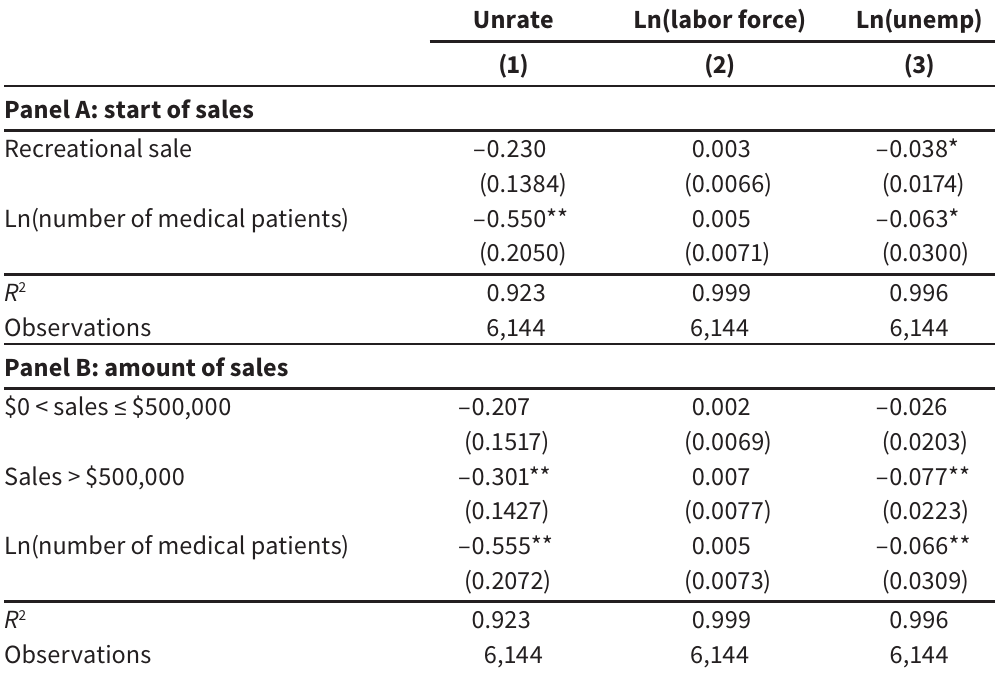
The effect of recreational dispensary entry and sales on the